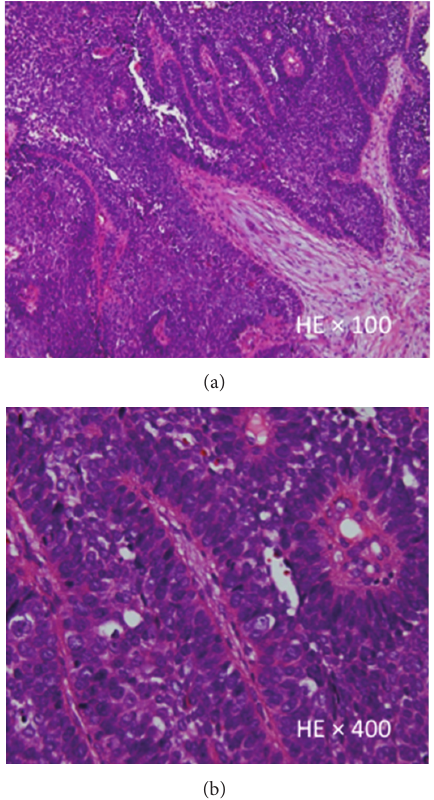
Figure 2: Lobulate or papillary alveolar forms were constructed by epithelial-like and basaloid tumor cells. These cells showed peripheral palisading, hyperchromatic nuclei with a high N/C ratio, and frequent mitosis (HE, × 100 and × 400).